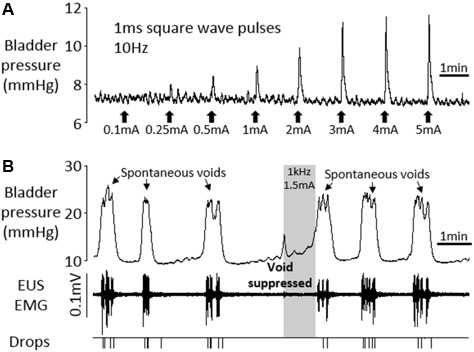
Terminal experiment under urethane anesthesia. (A) Graded increases in bladder pressure in response to 10 s periods of square wave pelvic nerve stimulation at 10 Hz, 1 ms pulses. (B) Voiding in response to continuous infusion of saline into the bladder (6 ml/h). High frequency pelvic nerve stimulation (1 kHz 1.5 mA sinusoidal waveform, gray panel) suppressed imminent spontaneous void.